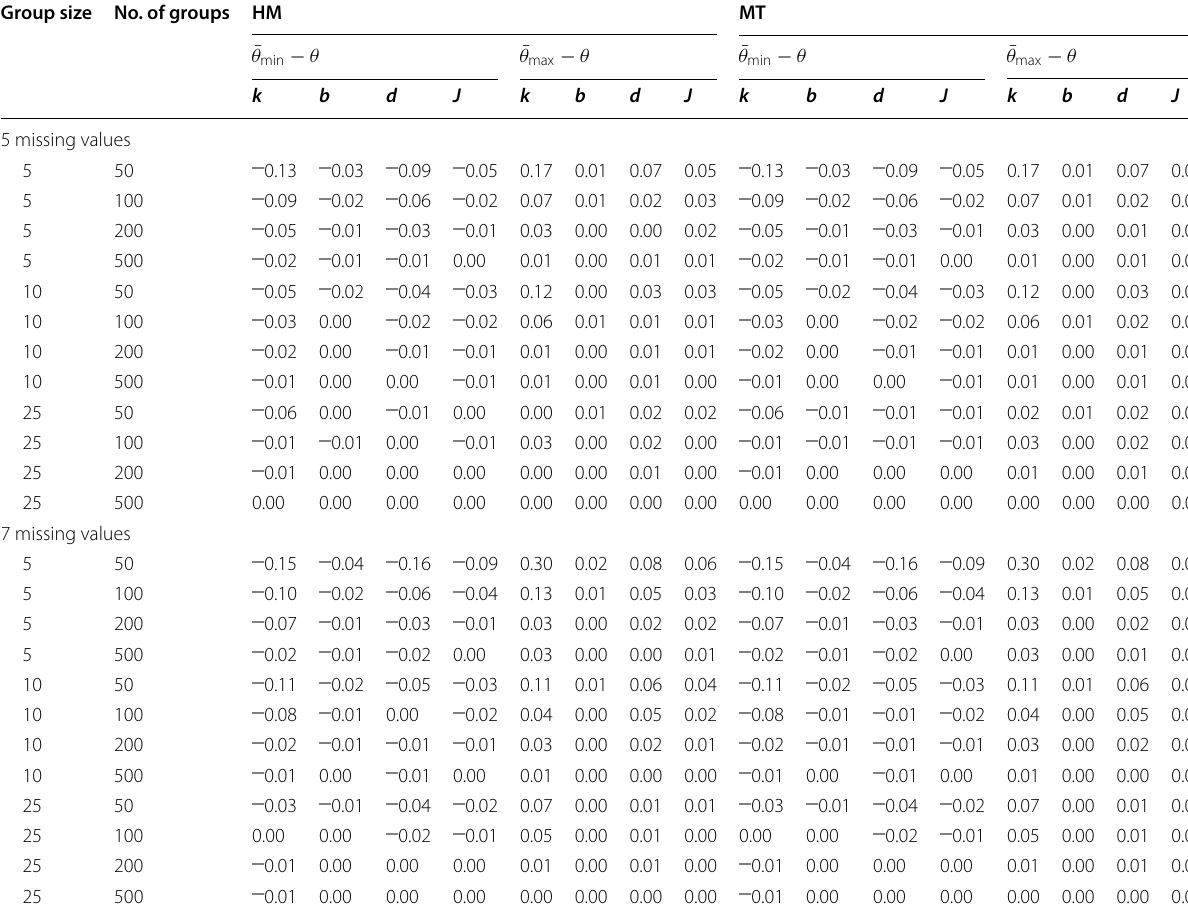
Table 9 Minimum and maximum bounds around the true coefficients of the Horowitz–Manski and Manski–Tamer estimators of the OLS endogenous social interactions model with non-closed groups and individuals excluded from their own peer group. 50 Monte Carlo simulations, 5 missing values in each simulation Group size No. of groups